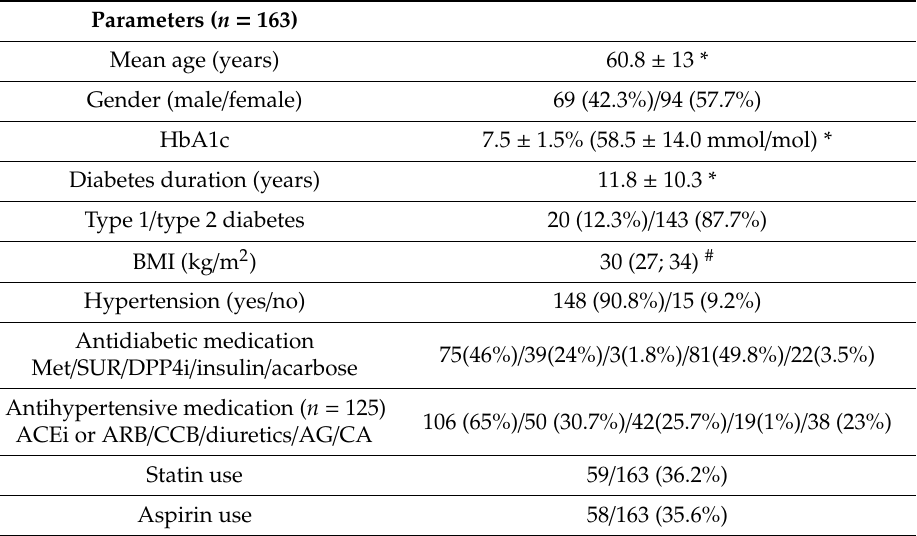
Table 1. Main clinical characteristics of the study